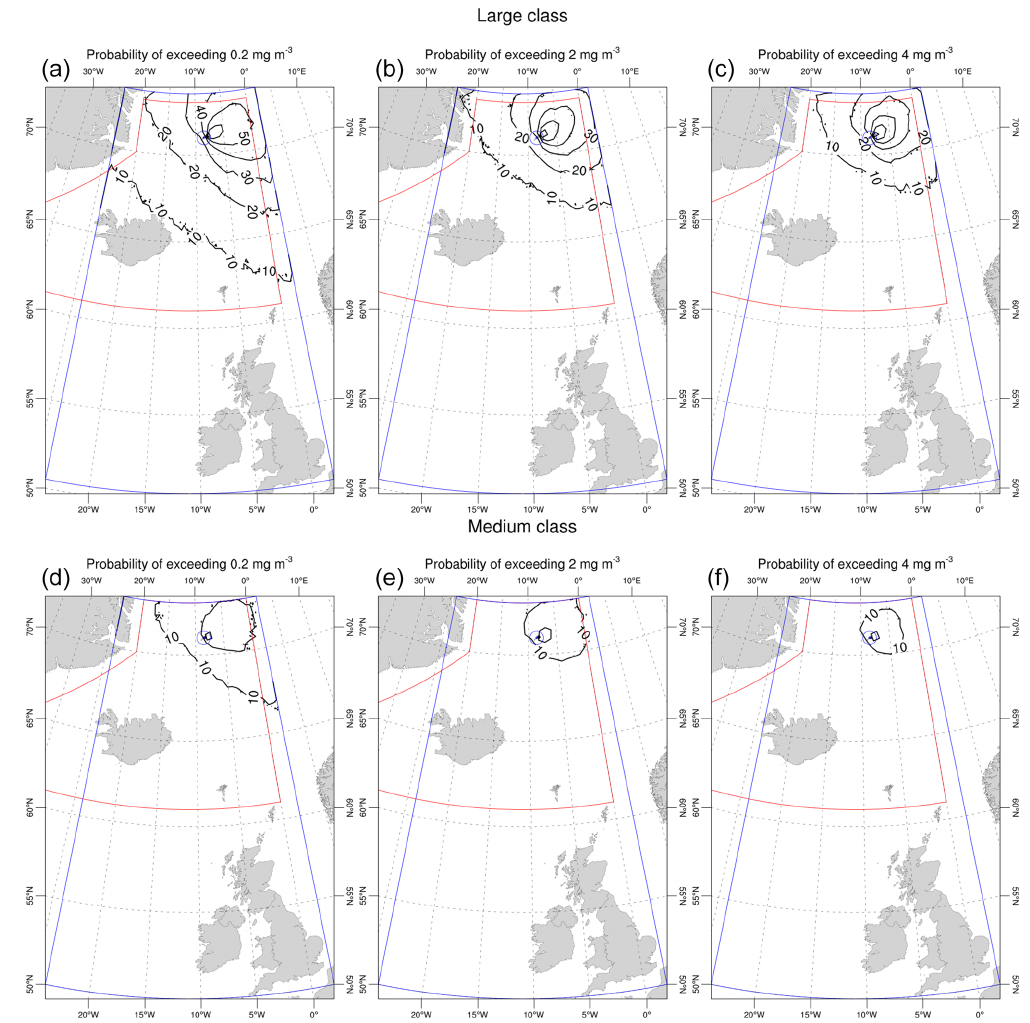
Figure D1. Exceedance probability maps at FL250: the isolines show the probability of reaching an ash concentration above 0.2mgm − 3 (a, d) , 2mgm − 3 (b, e) , and 4mgm − 3 (c, f) at FL250 at some time from the onset of the eruption to up to 48h after its